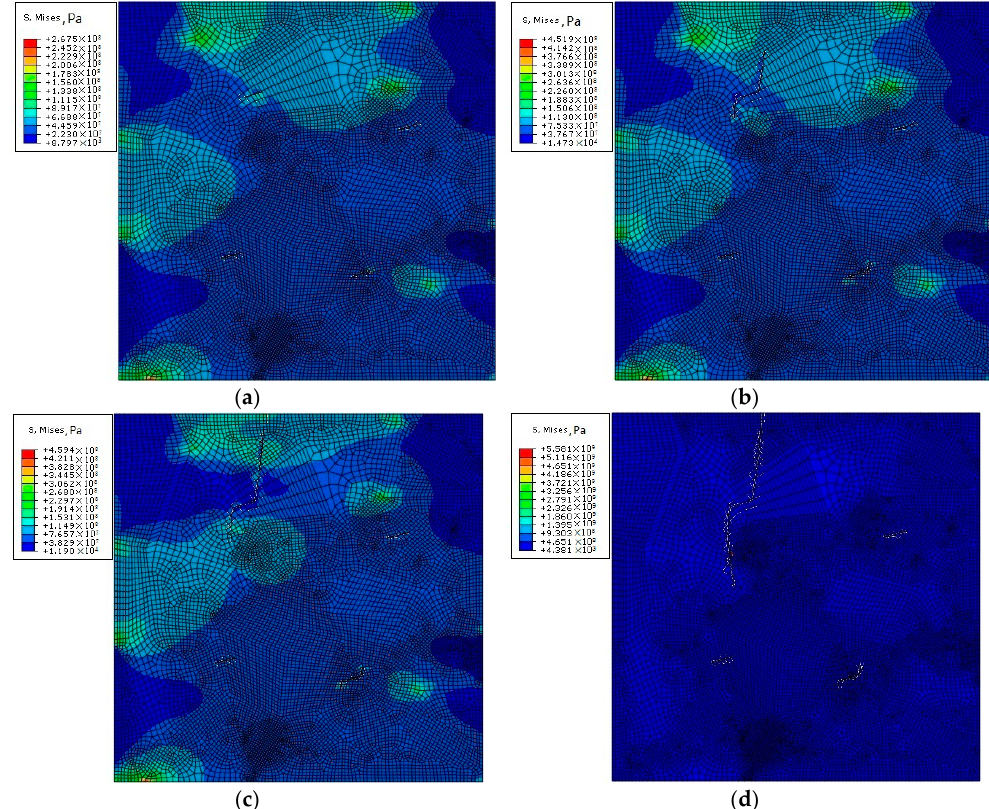
Figure 13. The ( a ) first stage, ( b ) second stage, ( c ) third stage, and ( d ) fourth stage of crack propagation with a load direction of 15°.